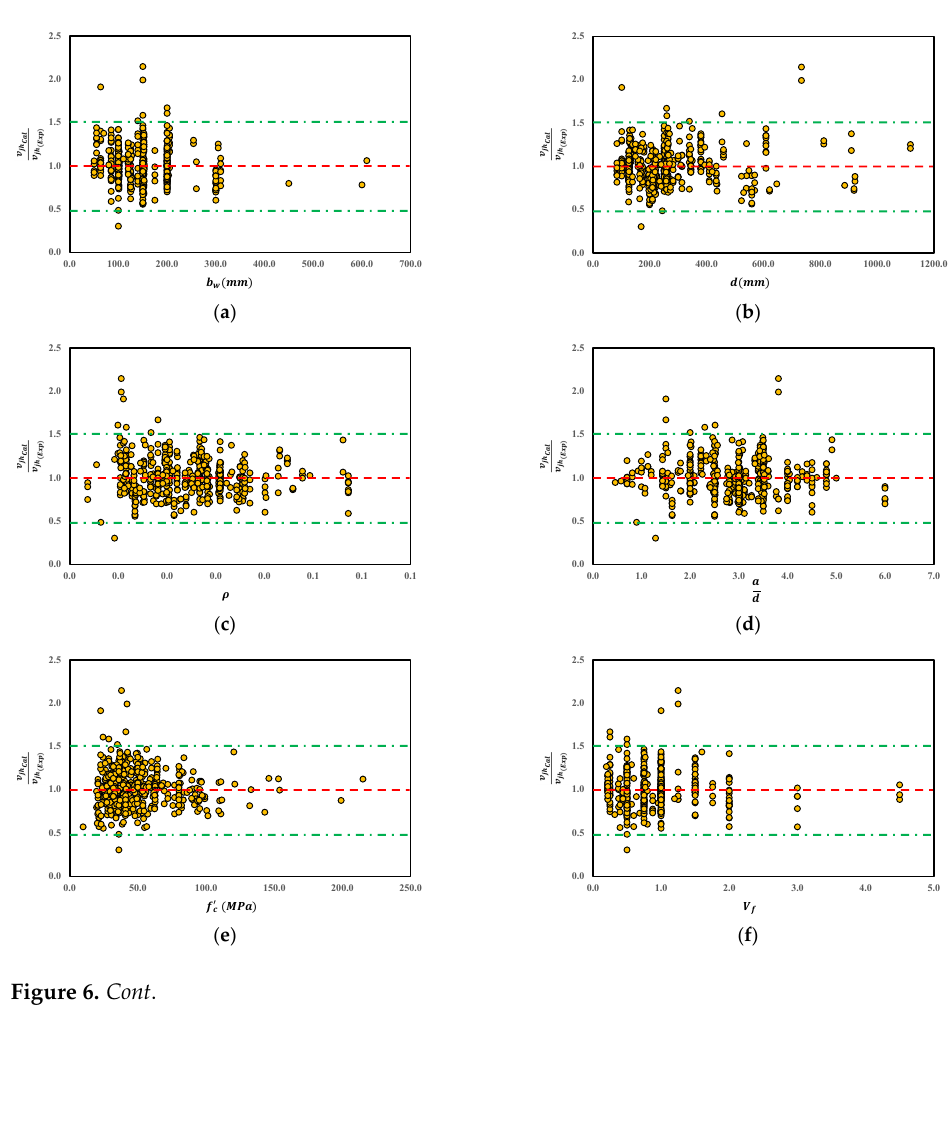
Figure 6. The predictive performance of the proposed steel fiber reinforced (steel fiber reinforced concrete (SFRC)) concrete beam shear strength model based on the main parameters. ( a ) Beam